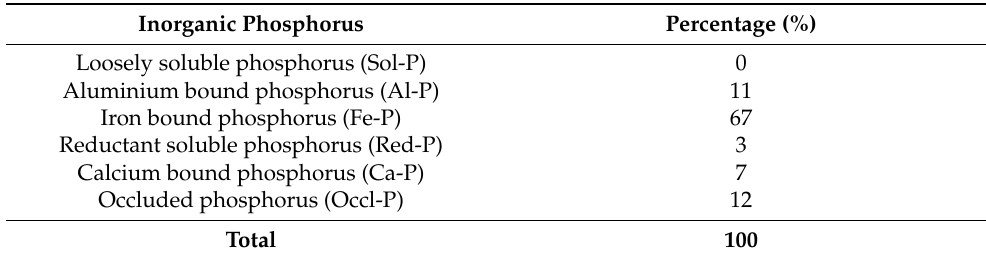
Table 2. Percentages of inorganic phosphorus speciation in soil before incubation